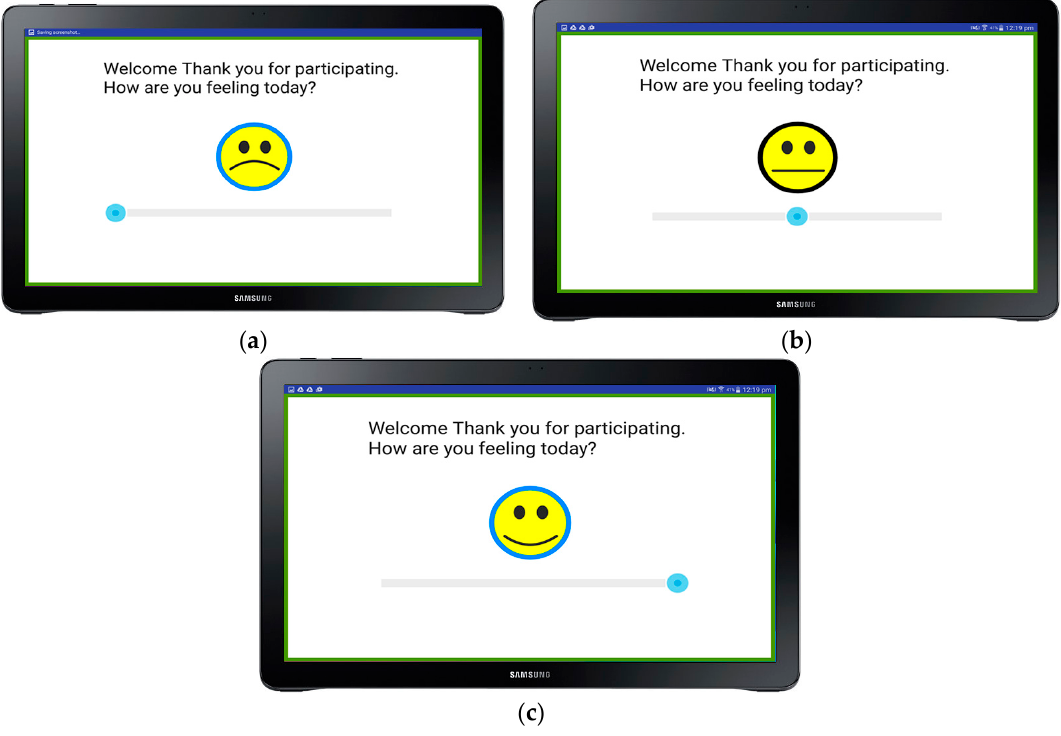
Figure 4. Welcome screen to validate the participants feelings when starting the test, showing: ( a ) the negative or sad face as the lower anchor, ( b ) the neutral for the middle anchor, and ( c ) the happy or positive side of the scale.